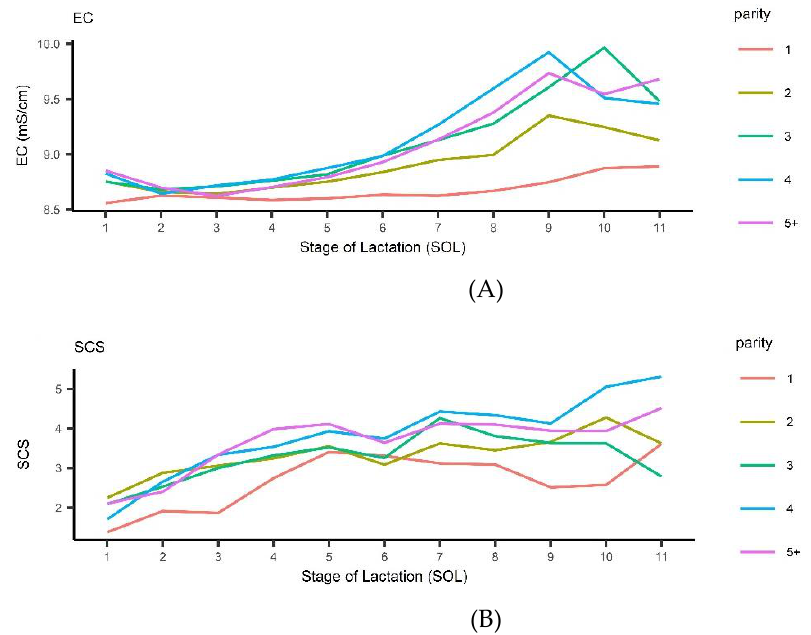
Figure 1. Italian Mediterranean Buffalo: observed trend for electrical conductivity (EC) ( A ) and Somatic Cell Score (SCS) ( B ) across stage of lactation and parity.